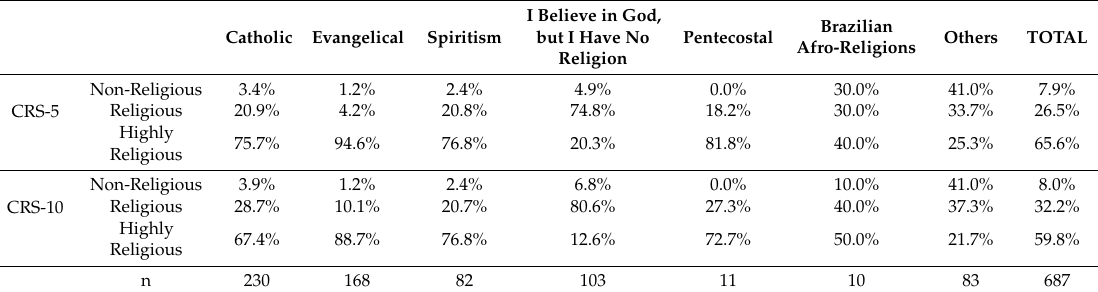
Table 9. CRS categorization between religions.